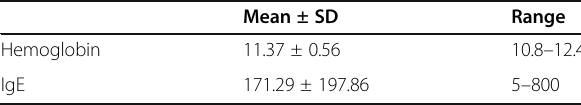
Table 1 Laboratory characteristics of the studied